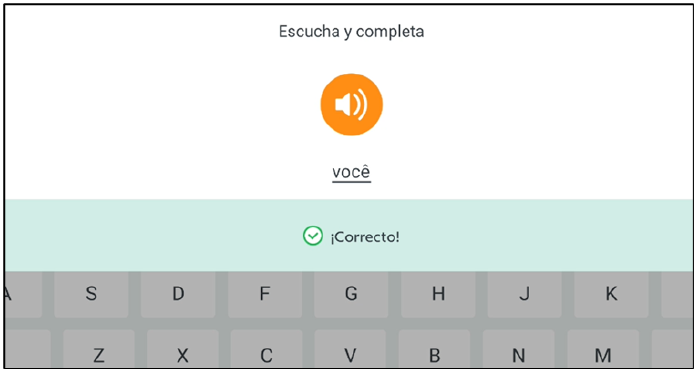
Figure 5. Option-selection activity and listen and complete sub-activity; Lesson 2.